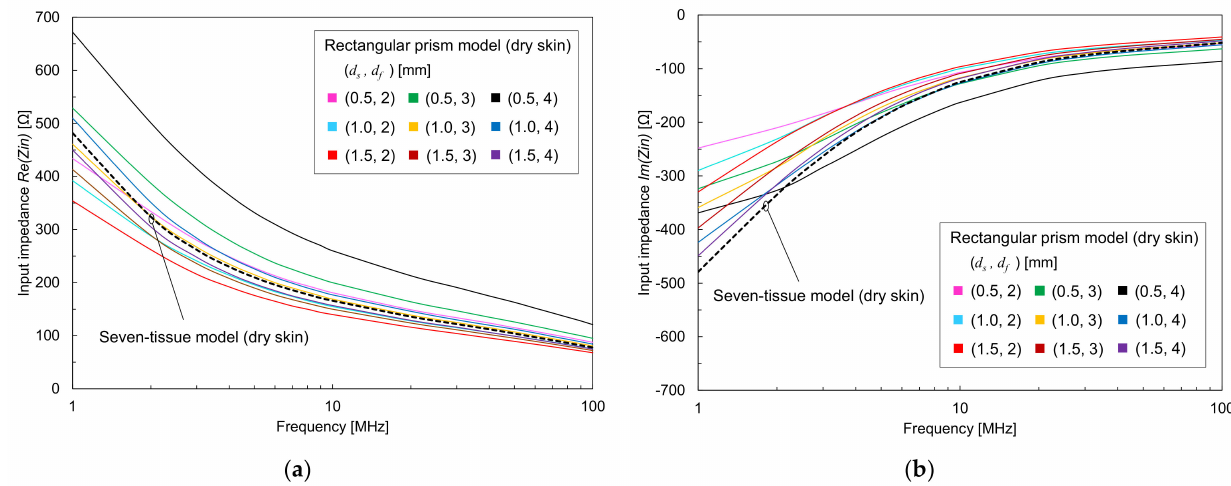
Figure 12. Input impedance characteristics of the wearable antenna calculated by using a simplified rectangular prism model with dry skin: ( a ) Real component of input impedance characteristics; ( b ) imaginary component of input impedance characteristics.